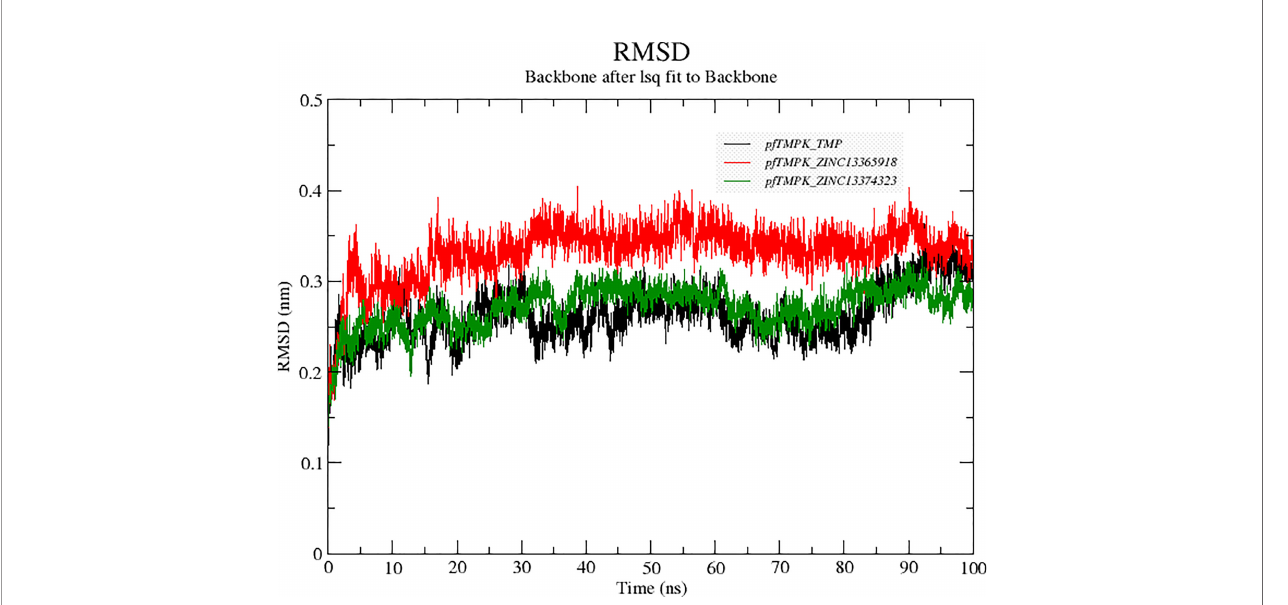
FIGURE 4 | Root mean square deviation (RMSD) graphs comparing the RMSDs of Pf TMPK in complex with its natural substrate (TMP) and the respective lead compounds. The RMSD graph for Pf TMPK – TMP is colored black, for Pf TMPK – ZINC13365918 red, and for Pf TMPK – ZINC13374323